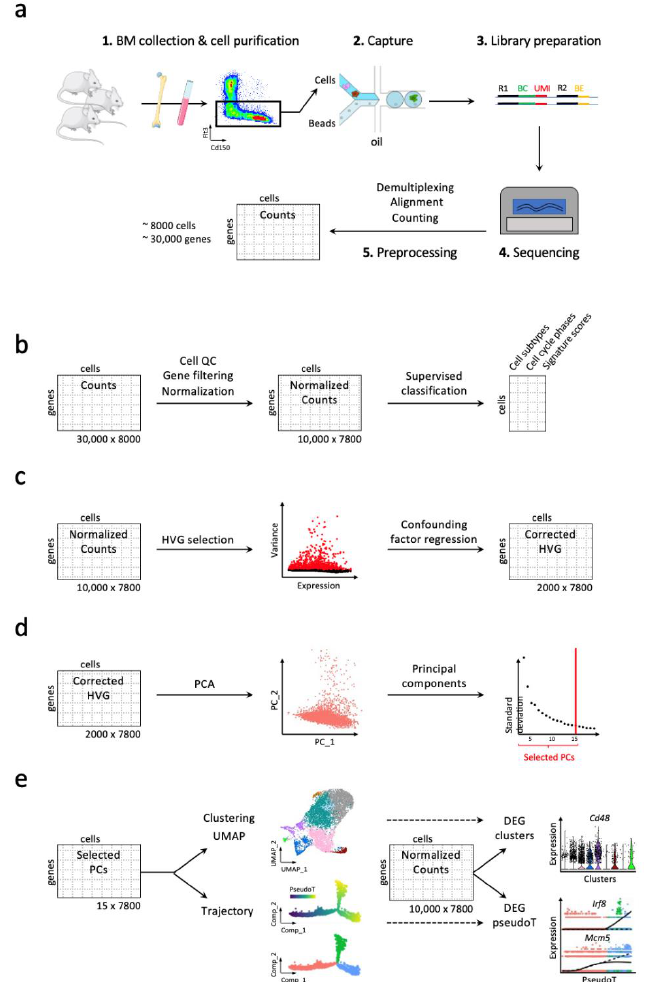
Figure 3. scRNA-seq workflow for studying hematopoiesis in mice. ( a ) Isolation, sorting, capture of cells of interest and preparation of libraries for a pool of mice. Example of a droplet-based